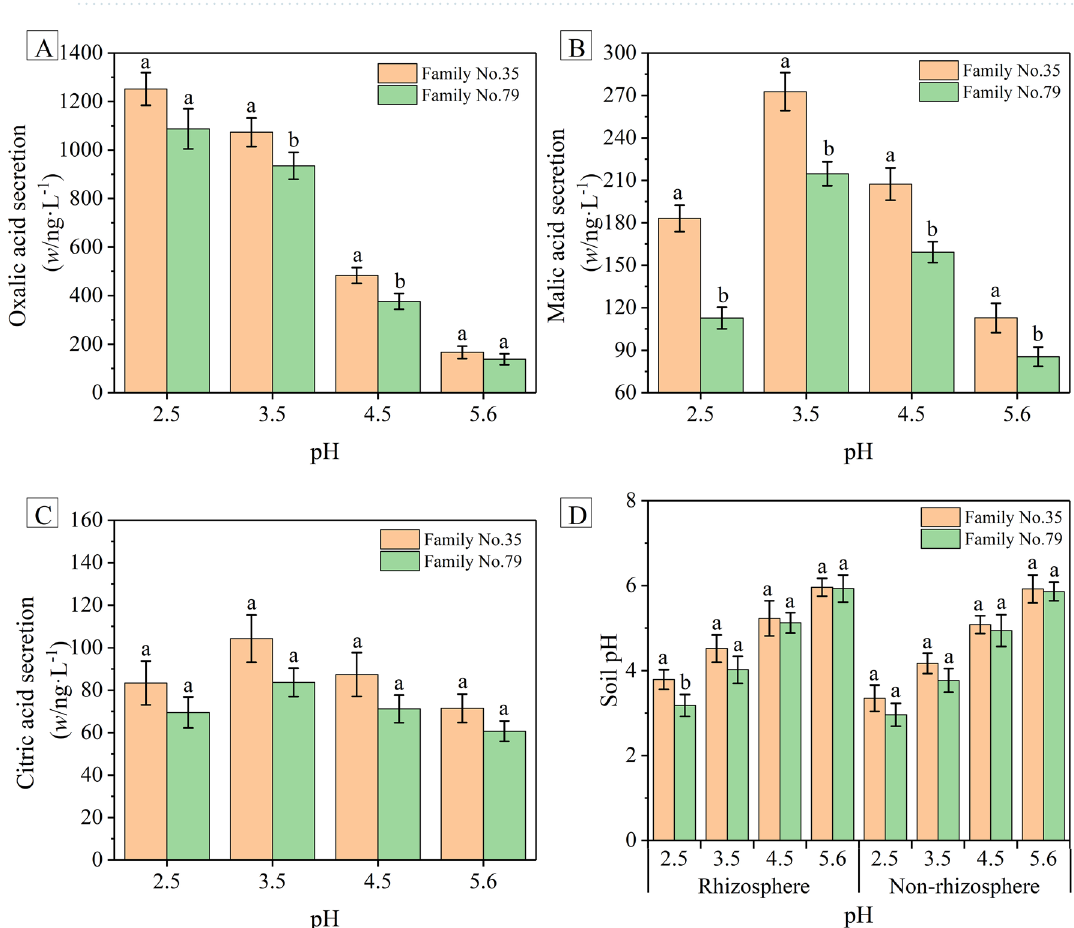
Figure 4. Root organic acids secretion, ( A ) oxalic acid ( w /ng L −1 ), ( B ) malic acid ( w /ng L −1 ), ( C ) citric acid ( w / ng L −1 ), and ( D ) soil pH of Pinus massoniana families Nos. 35 and 79. Based on Duncan’s multiple range tests with P < 0.05, significant differences between Masson pine family No. 35 and No. 79 are represented by lowercase letters. Results are expressed as mean ± standard error (n =